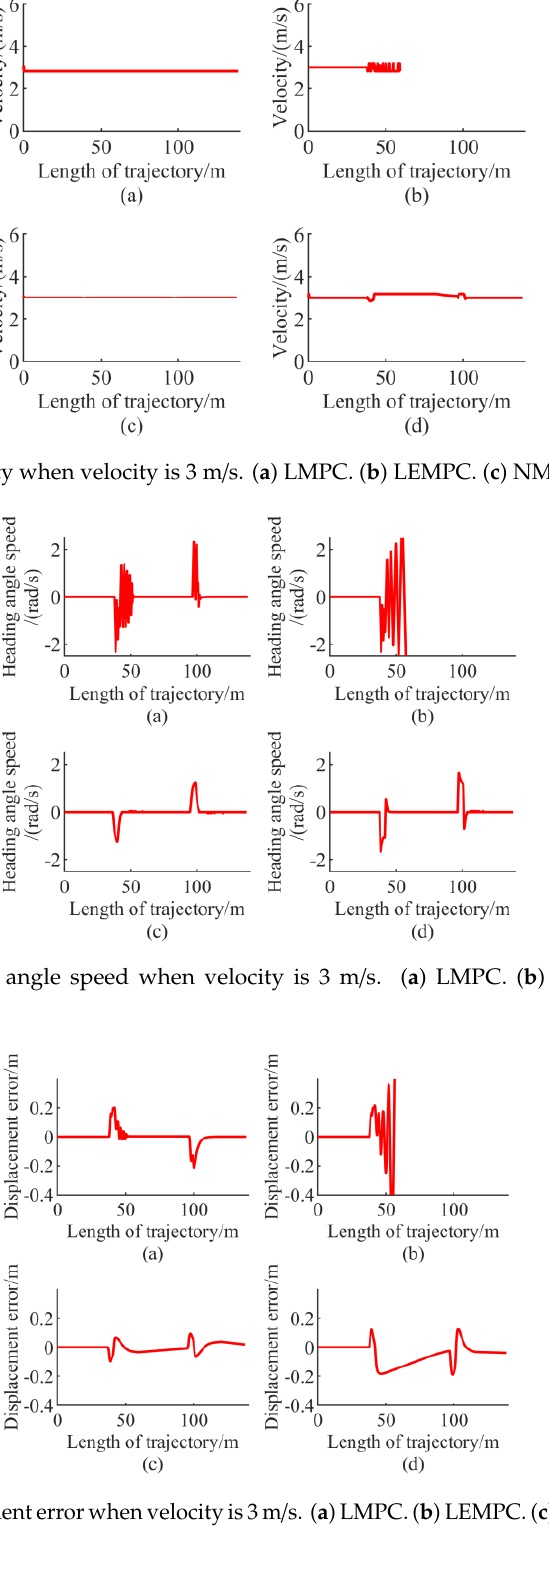
Figure 7. The trajectory when velocity is 3 m/s. The red line is the trajectory. The blue line is the reference path. ( a ) LMPC. ( b ) LEMPC. ( c ) NMPC. ( d ) NEMPC. The blue line is the reference path.